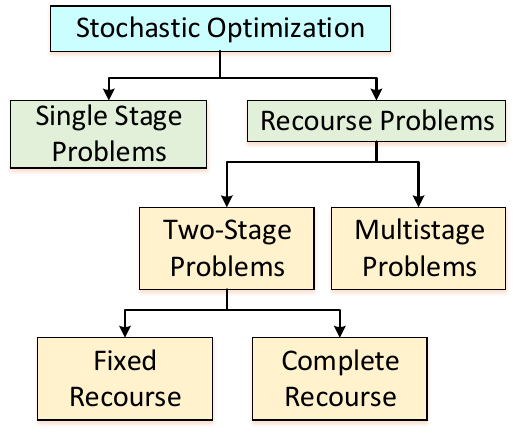
Figure 3. Taxonomy of stochastic